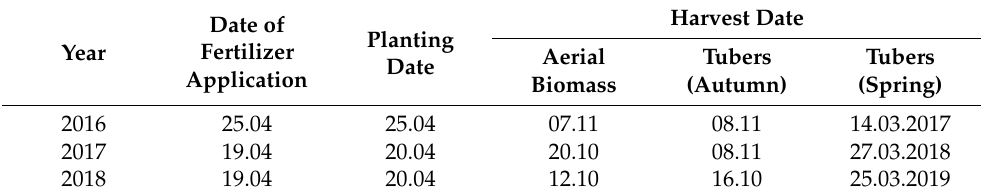
Table 1. Production technology of Jerusalem